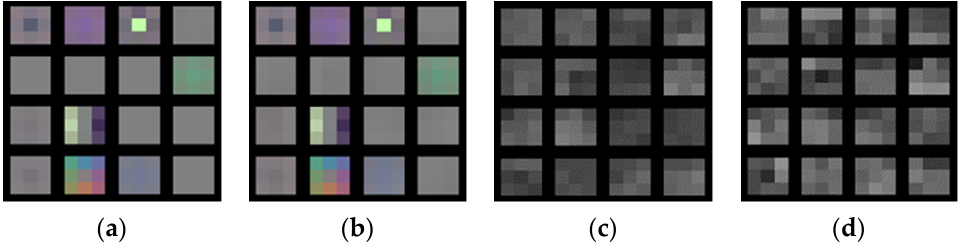
Figure 3. Sample filters of the VGG-16: ( a ) pretrained 1st convolutional layer, ( b ) 1st convolutional layer trained through transfer learning, ( c ) pretrained 10th convolutional layer, ( d ) 10th convolutional layer trained through transfer learning.